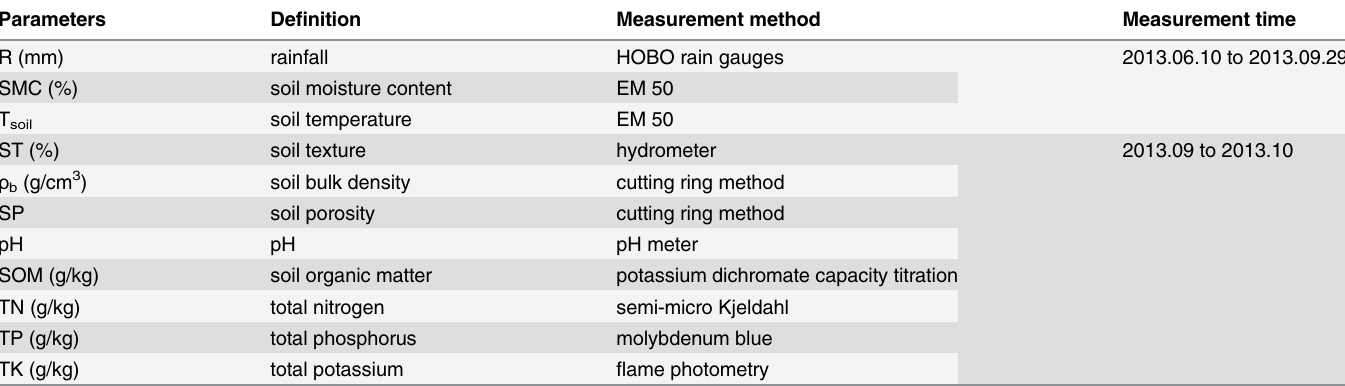
Table 1. Automatically and manually measured parameters.